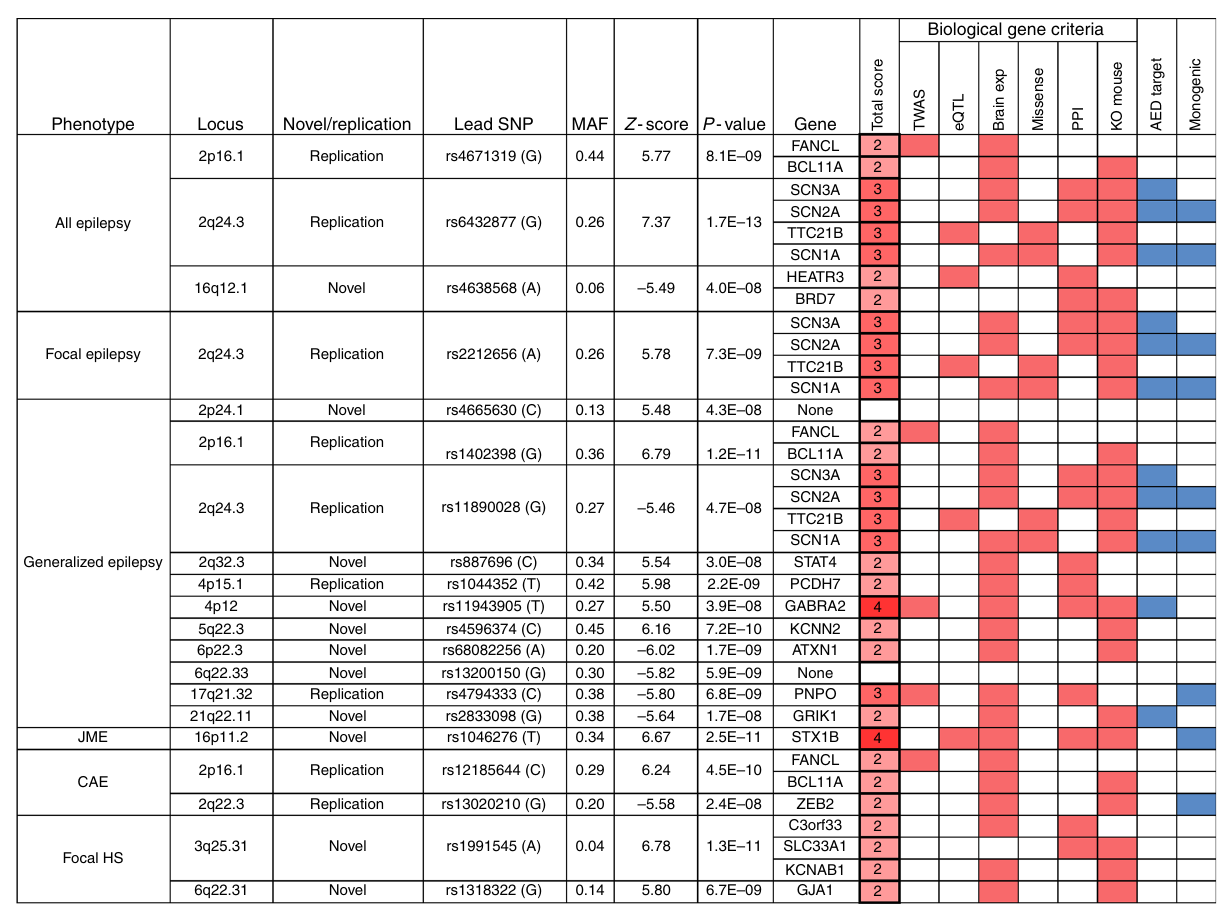
Fig. 2 Genome-wide signi fi cant loci of all analyses and prioritized biological epilepsy genes. Genes were prioritized based on 6 criteria and scored based on the number of criteria met per gene ( fi lled red boxes). The highest scoring gene, or multiple if they have the same score, in each locus is reported as ‘ prioritized biological epilepsy gene(s) ’ . Similar to previous studies 17,18 , we used a minimum score of 2 to de fi ne these genes and we noted ‘ none ’ if no gene in the locus reached this score. Filled blue boxes indicate overlap with known targets of anti-epileptic drugs and established monogenic epilepsy genes. The lead SNP is de fi ned as the SNP with the lowest P -value in the locus and the minor allele is displayed in brackets. P -values and Z -scores for All epilepsy, were calculated with BOLT-LMM. MAF minor allele frequency in the Human Reference Consortium reference panel. The direction of the Z -score is signed with respect to the minor allele. TWAS: signi fi cant TWAS association (based on data from the CommonMind Consortium), eQTL: signi fi cant eQTL within locus (based on data from the ROS/MAP projects), Brain exp: the gene is preferentially expressed in the brain, Missense: epilepsy GWAS missense variant in locus, PPI: gene prioritized by protein-protein interaction, KO mouse: relevant knockout mouse